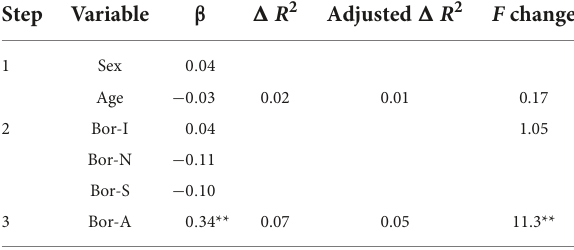
TABLE 3 Summary of hierarchical regression